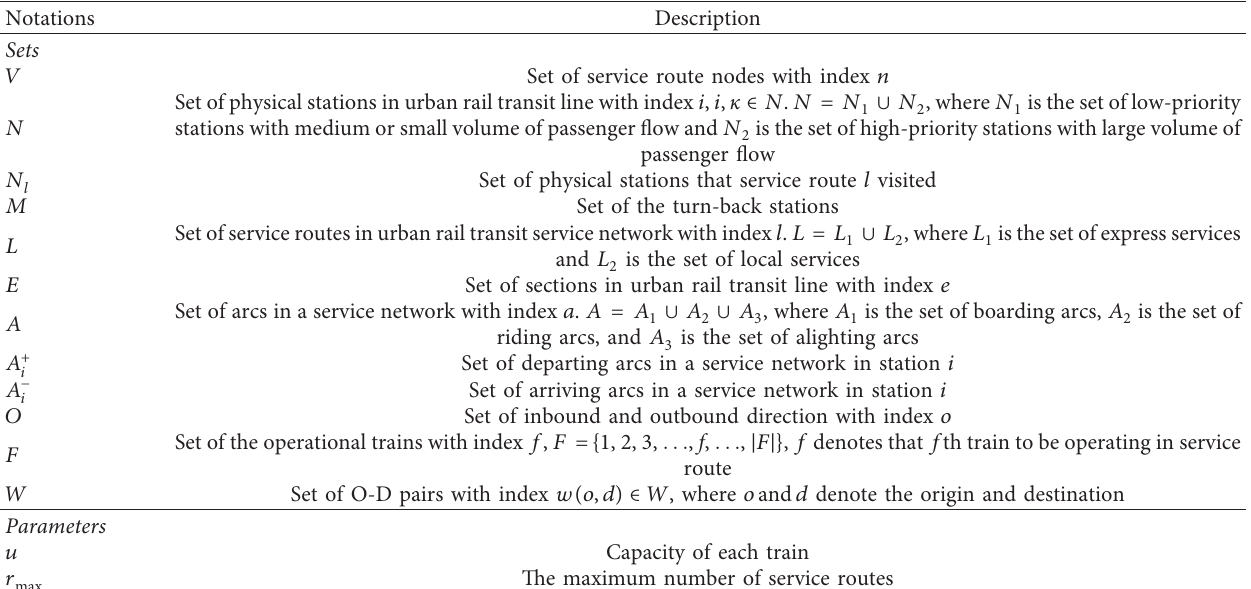
Table 2: Definition of sets, indices, parameters, and